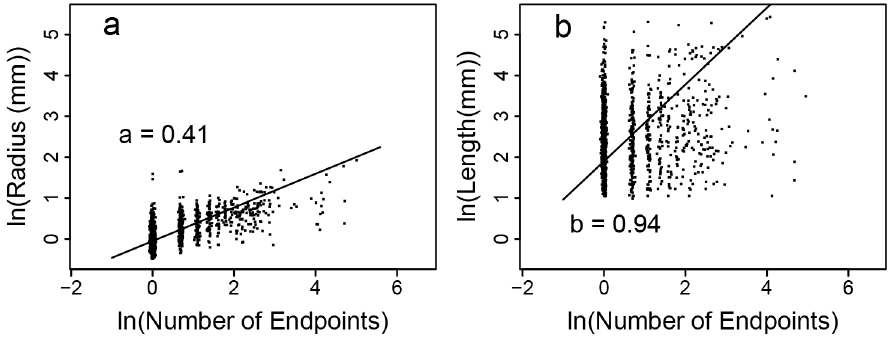
Fig 4. Regression-Based Exponent Fits. Standard Major Axis regression (see Methods) of (a) the log of radius, ln r , and (b) the log of length, ln l , against the log of the number of downstream tips, ln N d . Fit lines and slope values are shown. Correlation coefficients ( R 2 ) are 0.66 and 0.19, respectively ( P < 0.01 for